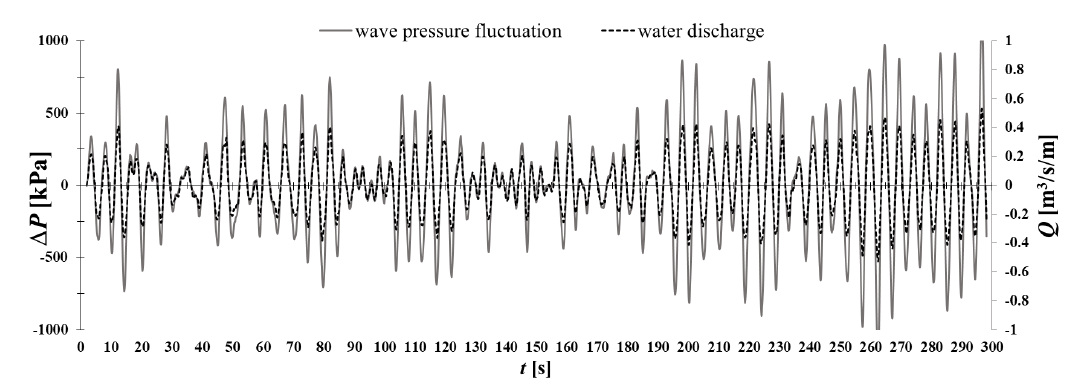
Figure 8. A 300s time history of the instantaneous wave pressure fluctuation and water discharge on the outer opening of the